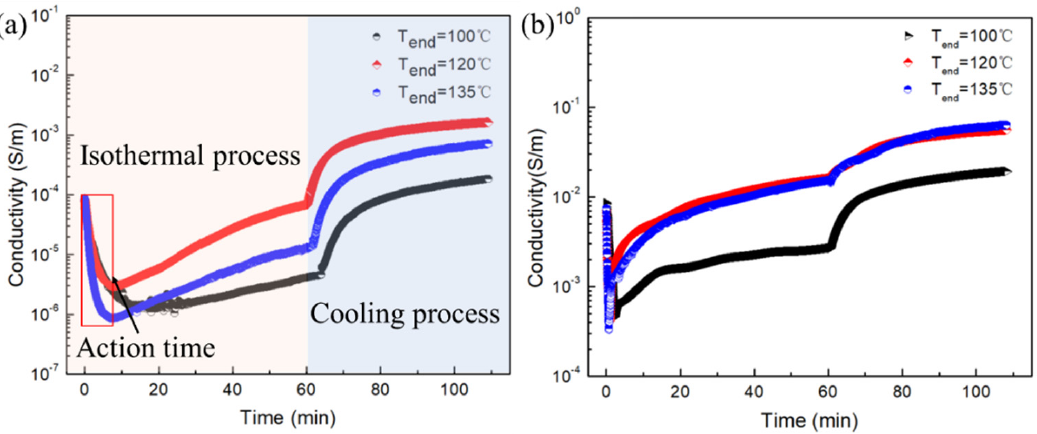
Figure 5. The temperature response behavior of PLAGNP 3.5 ( a ) and PLAGNP 3.5 PB 20 composites ( b ). Table 2. The relative conductive parameters and DSC data at different heat treatment tempera- tures.